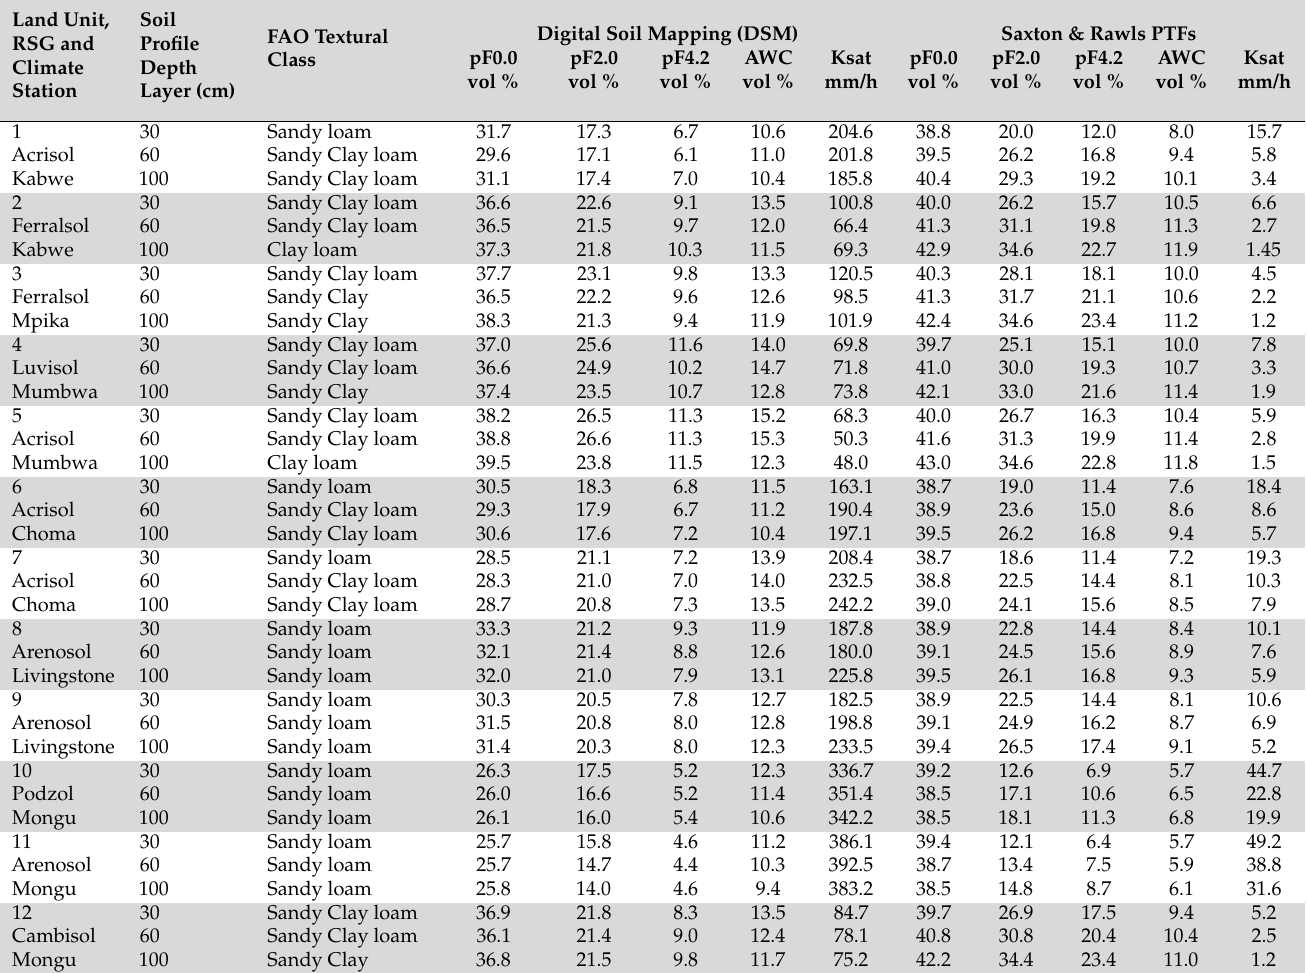
Table 2. Soils and soil hydraulic properties data for AquaCrop simulations as generated through DSM (based on ANN derived PTFs and Random Forest regression with Residual Kriging), and the Saxton and Rawls